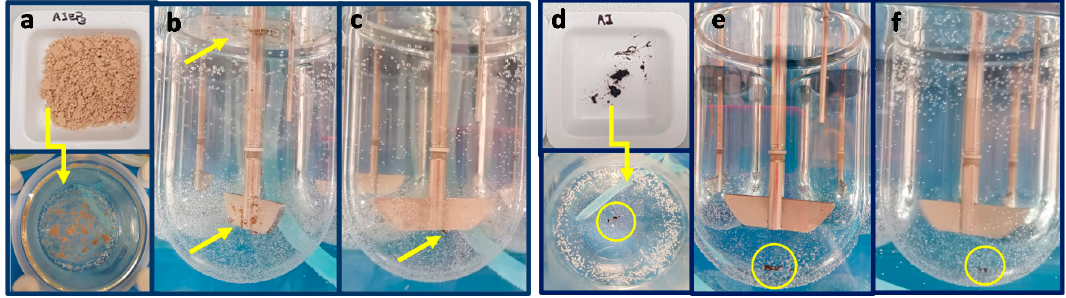
Figure 12. Pictures of water dissolution behaviour AJEP 3 ( a – c ) and AJ raw extract ( d – f ): loading phase ( a , d ); one minute from the start of the test ( b , e ); and, five minutes from the start of the test ( c , f ).